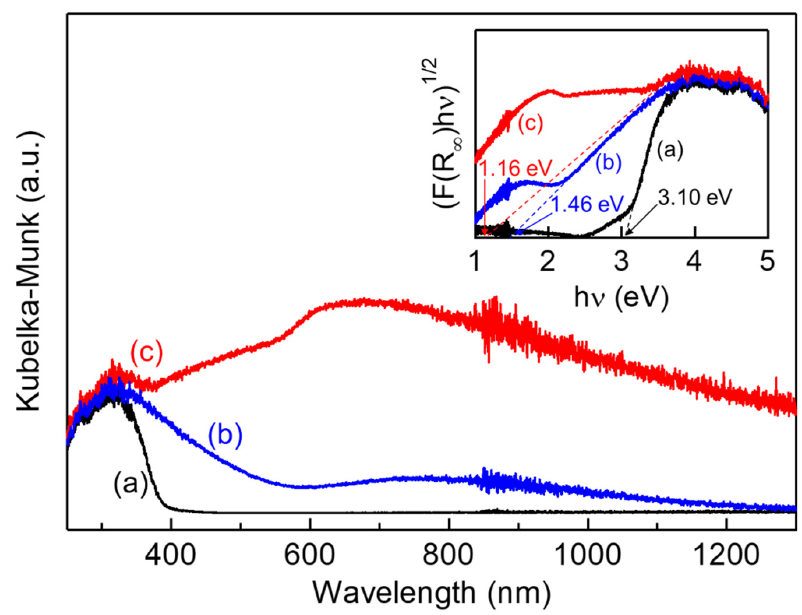
Figure 2. Diffuse reflectance spectra of ( a ) TiO 2 , ( b ) Cu-TiO 2 , and ( c ) Cu-TiO 2 -H samples. The inset is the Tauc plots for the determination of the bandgap of the samples.